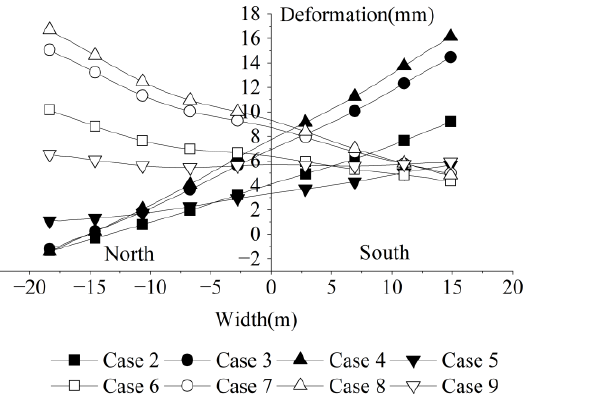
Figure 9. Typical analysis section of tunnel frame structure.